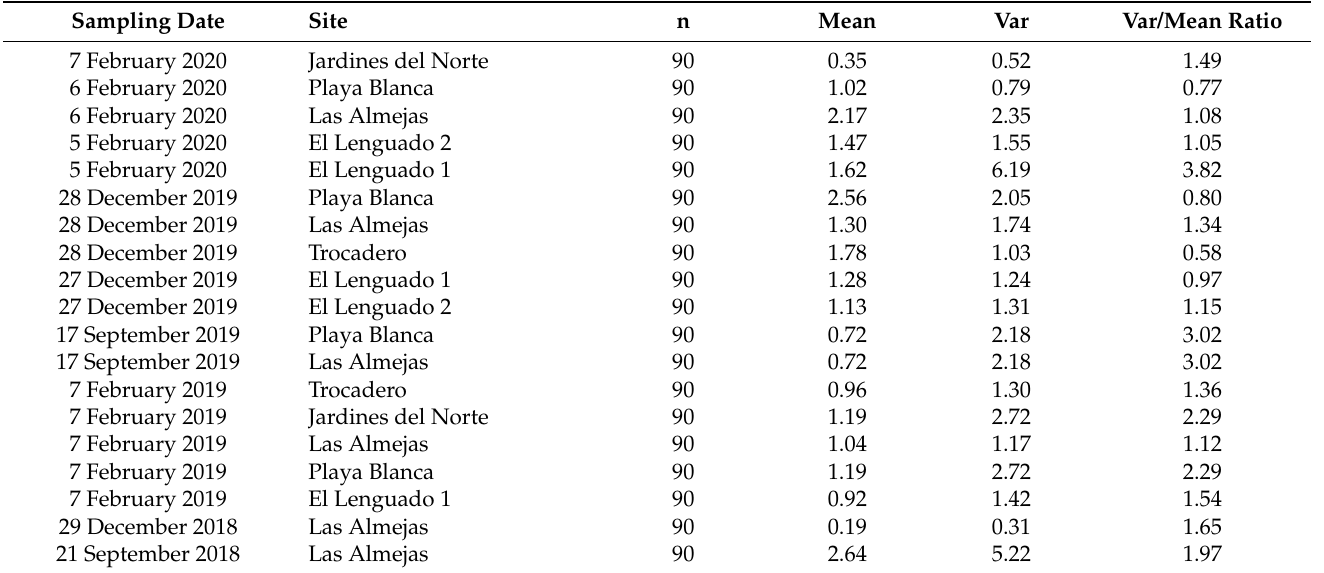
Table 2. C. cinereus mean density (ind/grid 10 × 10 cm), variance (var) and variance/mean ratio for sampling events.